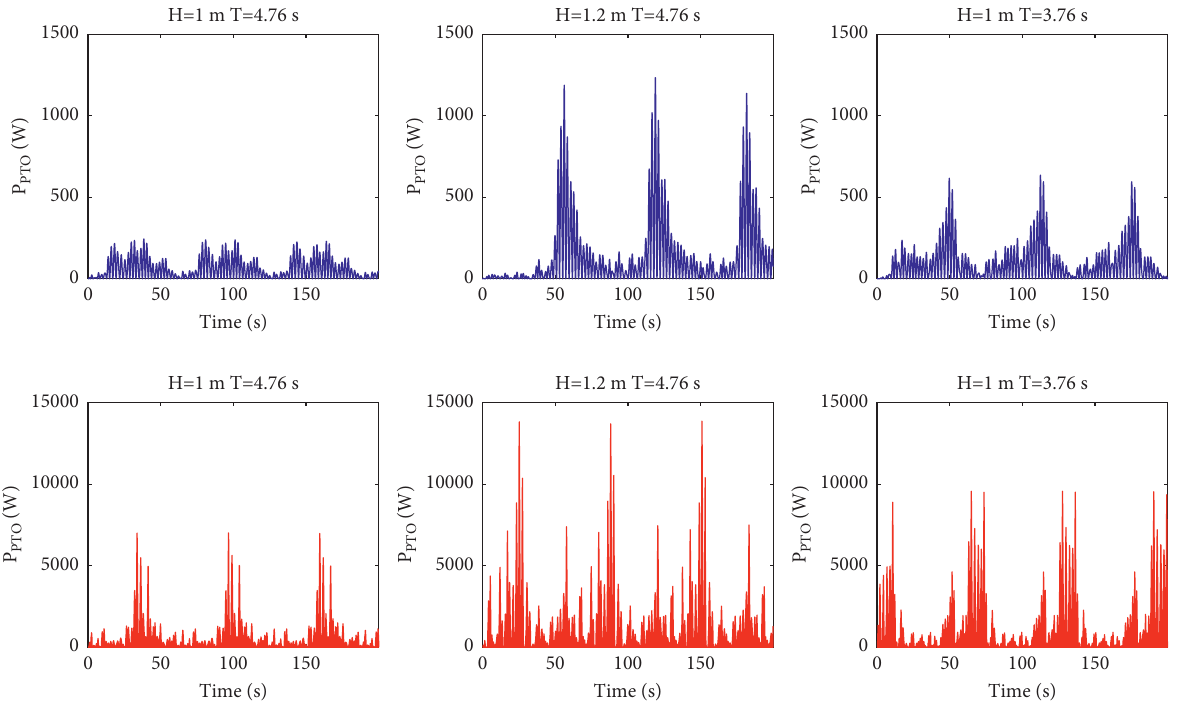
Figure 6: The power generation performance comparison of the gyroscopic system under the random wave circumstance using LQR and NMPC, respectively. The red curve represents the NMPC controller, and the blue curve represents the LQR